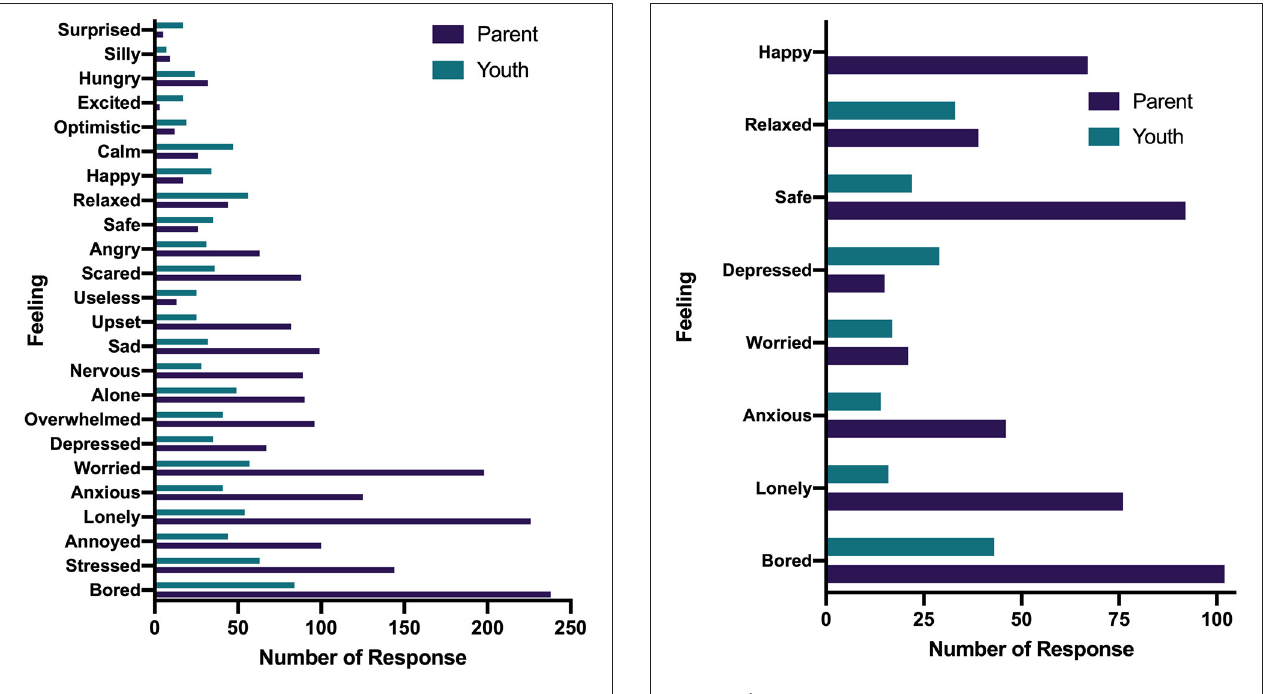
Healthy Movement Behaviors reported by parents and youth are provided in Table 3